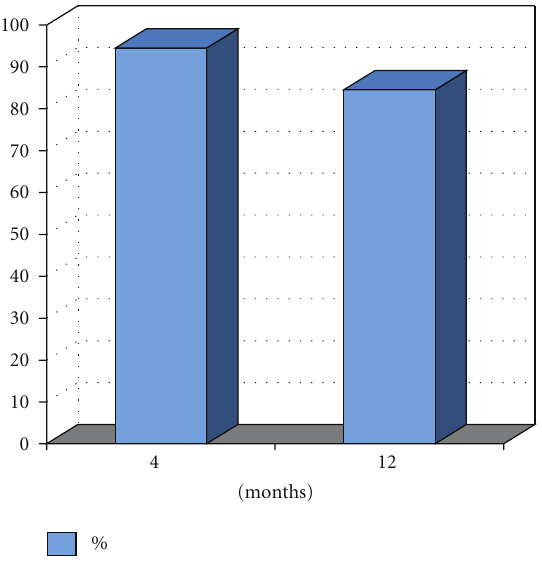
Figure 7: Percentage of implant portion included in bone 4 months after implantation and 12 months after prosthesis